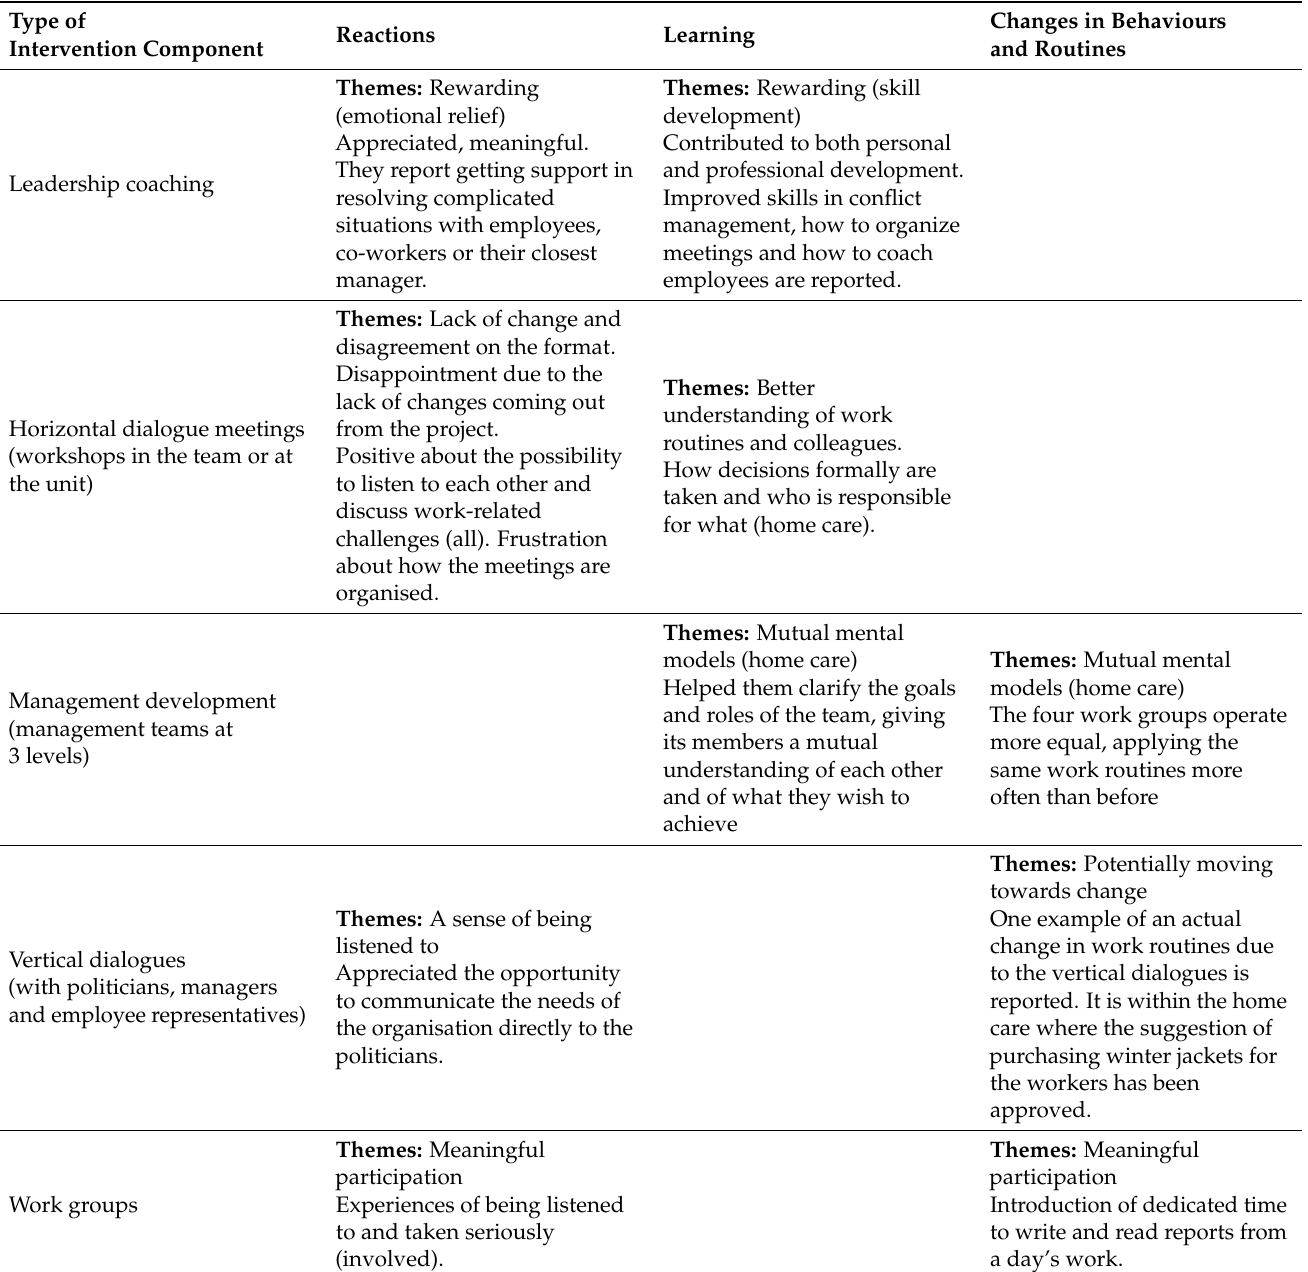
Table 6. Main findings from the thematic